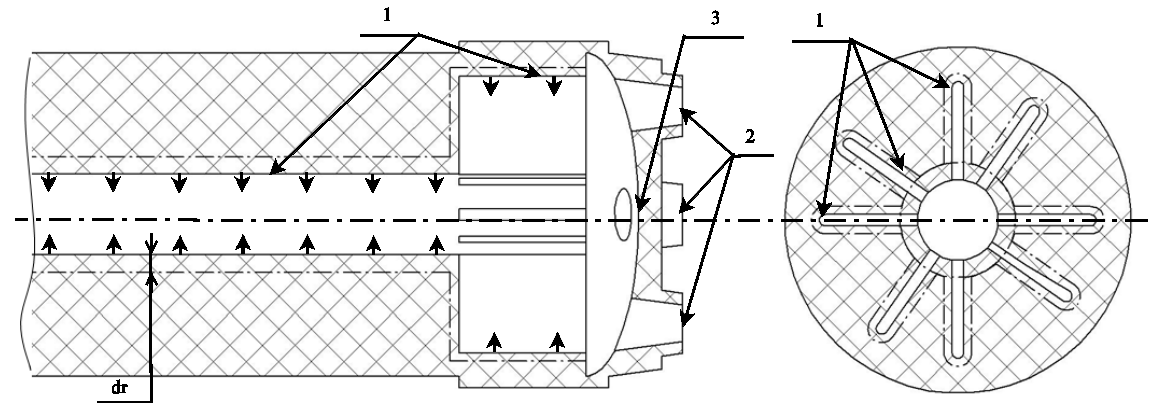
Figure 1. Calculation area: 1–the mass supply surface, 2–nozzle outlet, 3–nozzle bottom.